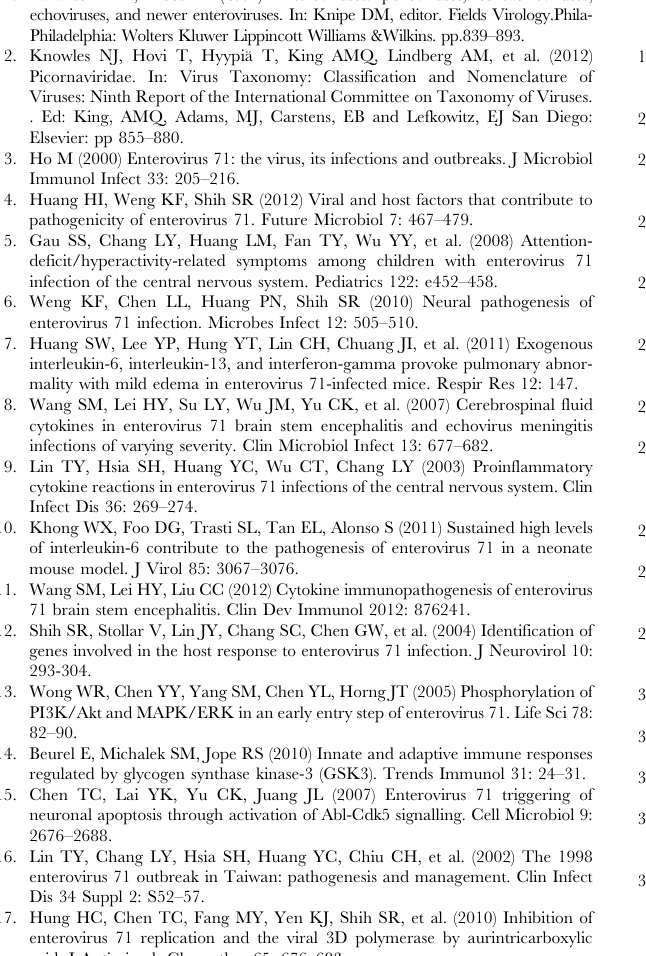
ANOVA: *P , 0.05, **P , 0.001 *: compared to the percent of infected cells by treatment with A77172. (TIF) Figure S3 Inhibitory effects of A771726 on EV71- induced CPEs and the reversal of EV71-induced CPEs by uridine. Cells were infected with EV-A71 (moi 0.5), and various concentrations of A771726 and uridine were added to the infected cells. SF268 cells were all lysed at 72 h after EV-A71 infection, as shown in the VC (virus control) column. Measure- ments were made in three independent experiments.